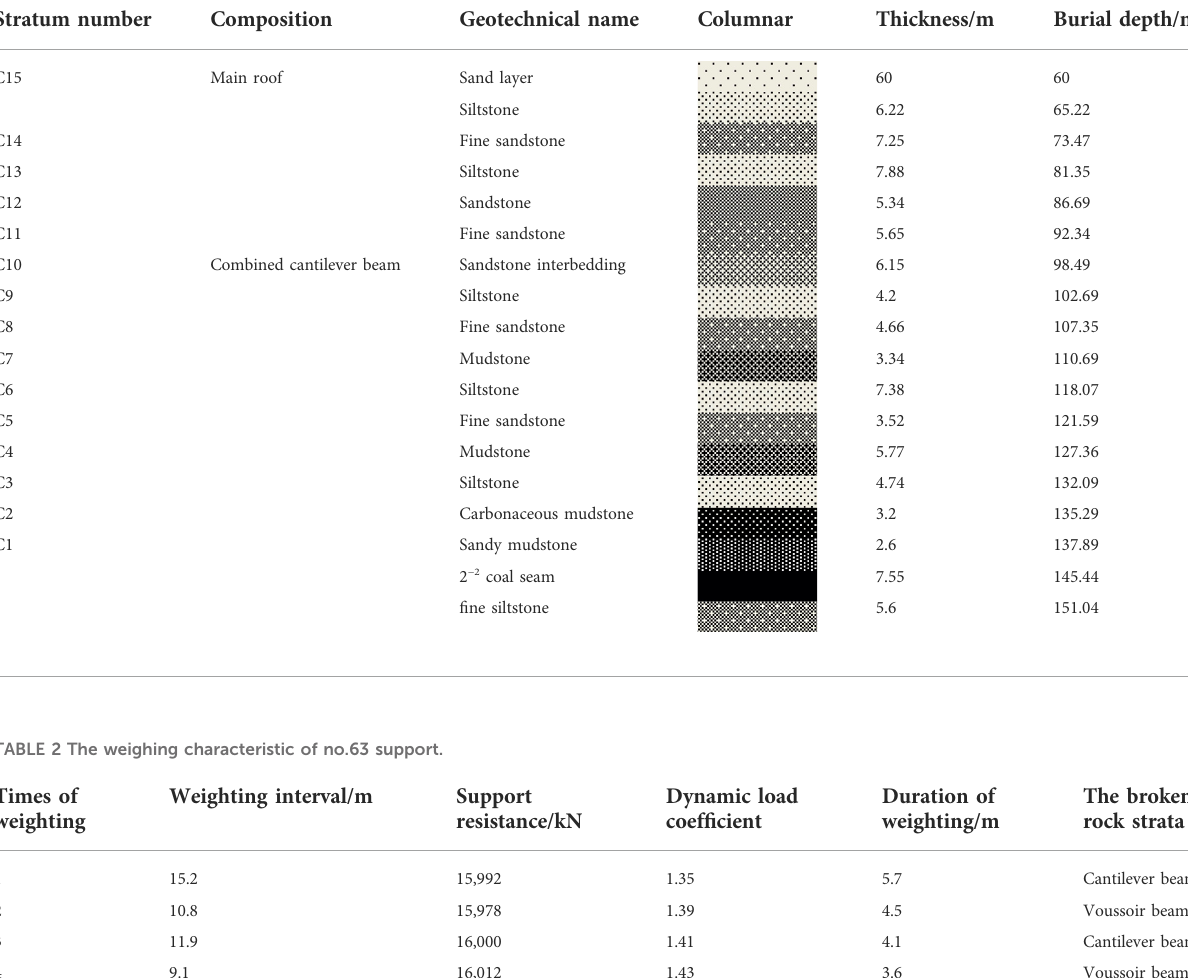
TABLE 1 Lithology of the no. 22310 working face.